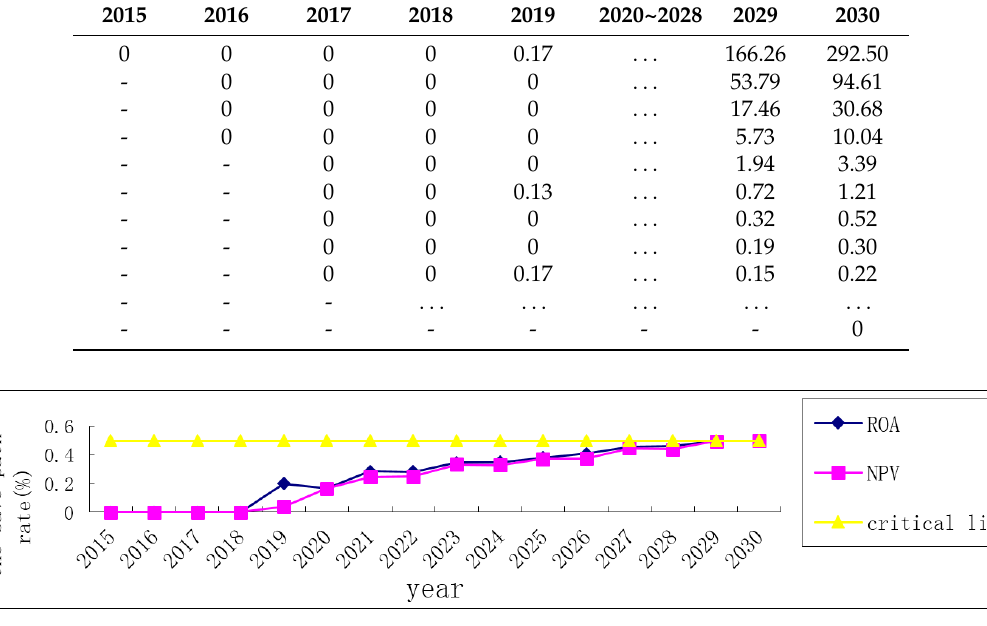
Figure 7. Curve of the save-path rate based on ROA and NPV.